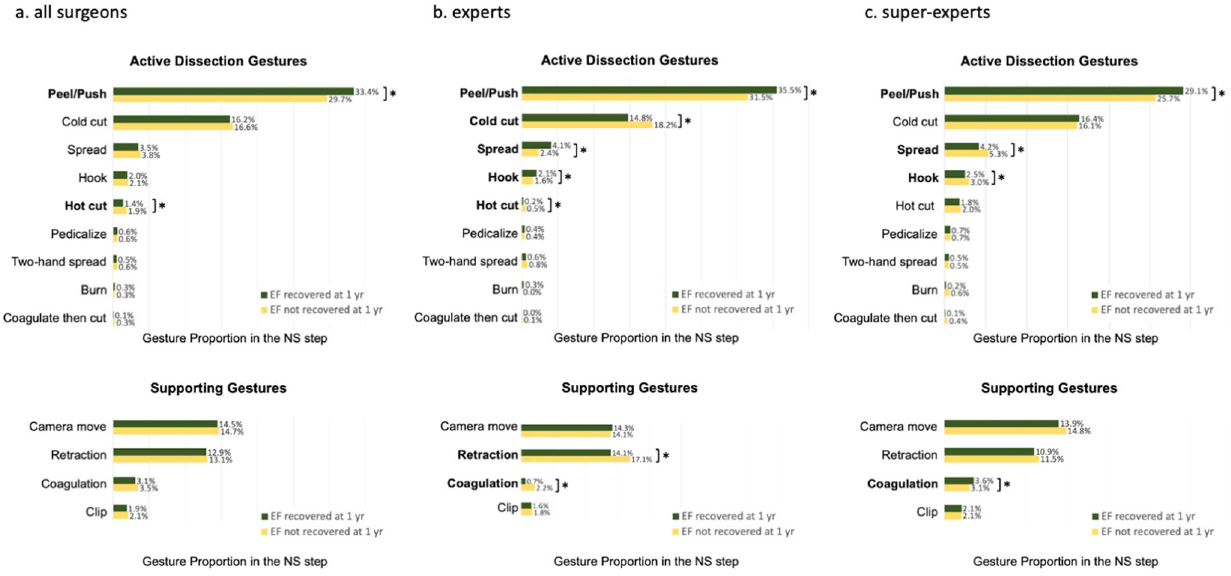
Fig. 3 Comparison of surgical gestures in the nerve-sparing step between patients who recovered erectile function (EF) at 1 year and patients who did not recover EF at 1 year (* p < 0.05, generalized linear mixed model). a The whole cohort; b expert group; c super- expert